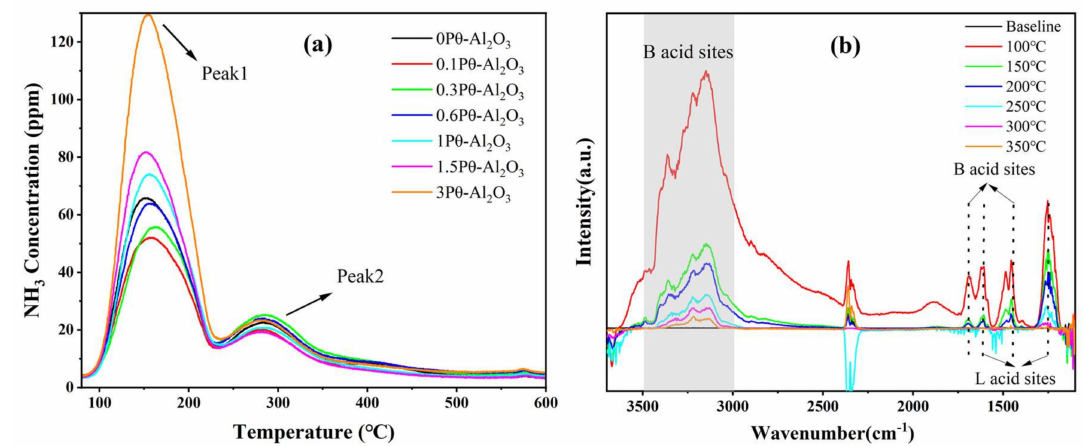
Figure 2. ( a ) NH 3 − TPD profiles of the supports. ( b ) NH 3 − IR profiles of θ -Al 2 O 3